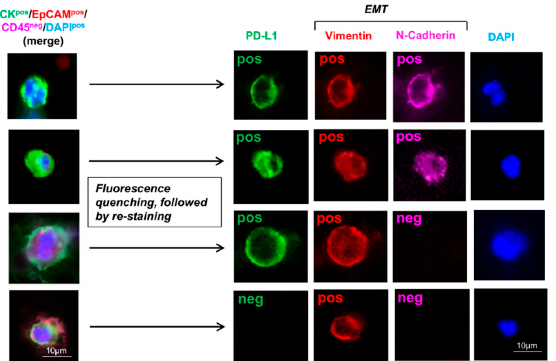
Figure 1. CK pos / EpCAM pos / CD45 neg CTCs and CTC expression analysis for PD-L1, vimentin, Figure 1. CK pos /EpCAM pos /CD45 neg CTCs and CTC expression analysis for PD-L1, vimentin, and N- Cadherin in NSCLC patients. 7.5 mL blood was drawn, CTCs were enriched by microfilter isolation